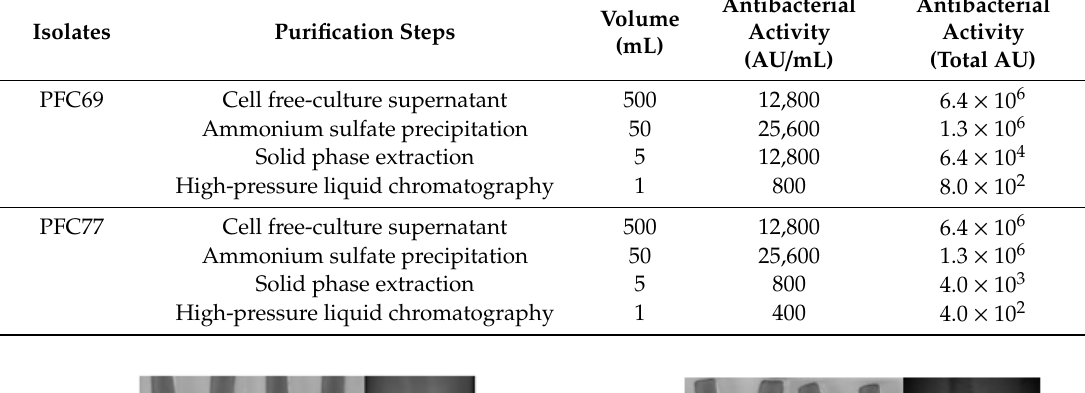
Table 3. Bacteriocin activities produced by P. acidilactici PFC69 and L. lactis PFC77 in the purification steps .